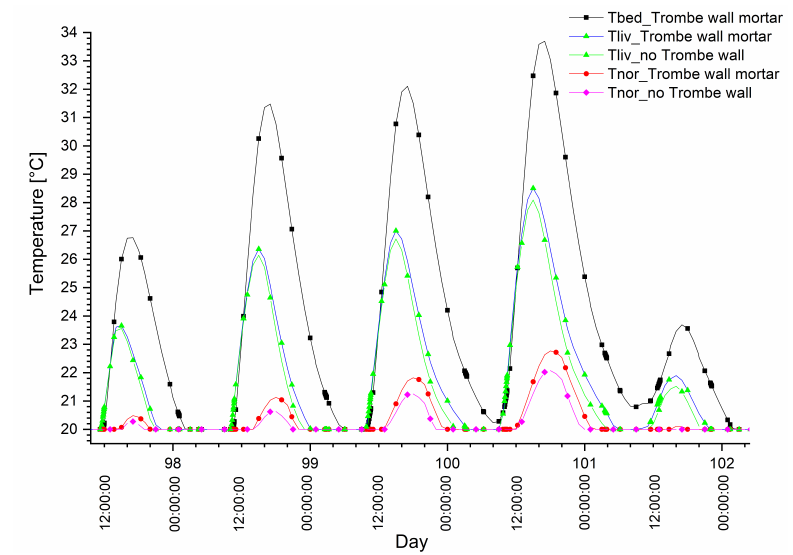
Figure 14. Comparison of temperatures in the living room and north-facing rooms for the case of the bedroom equipped both with and without the mortar solar Trombe wall. Table 7. Annual heating demands in the bedroom, living room and north-facing rooms, for the Paris weather